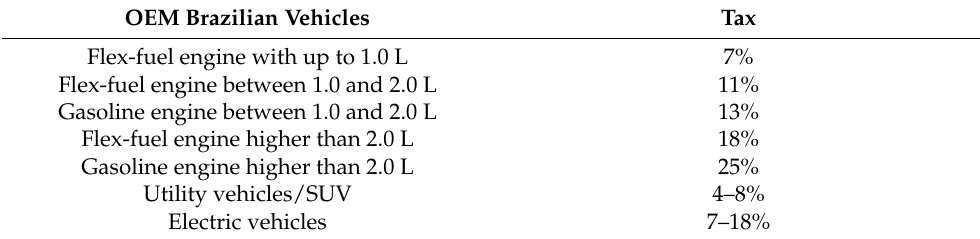
Table 1. Brazilian vehicle manufacturing tax [29].